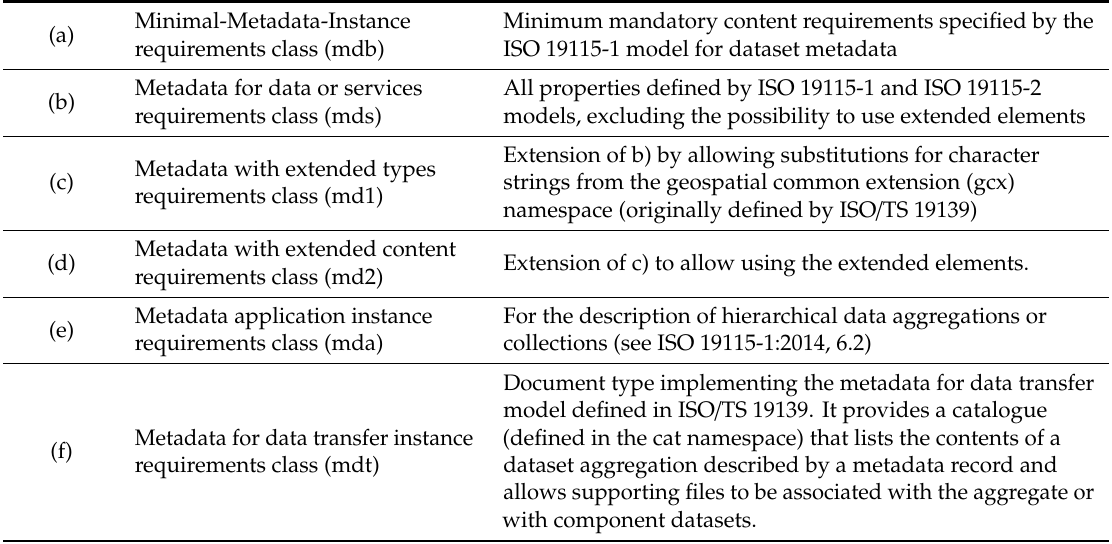
Table 5. Conformance classes for metadata instance document